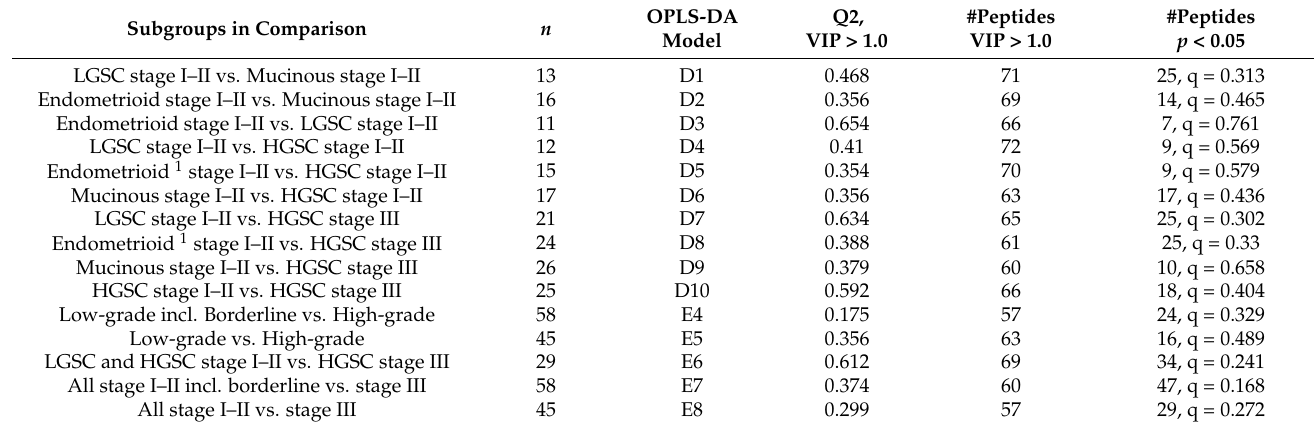
Table 3. Comparison between malignant subgroups. Subgroups in